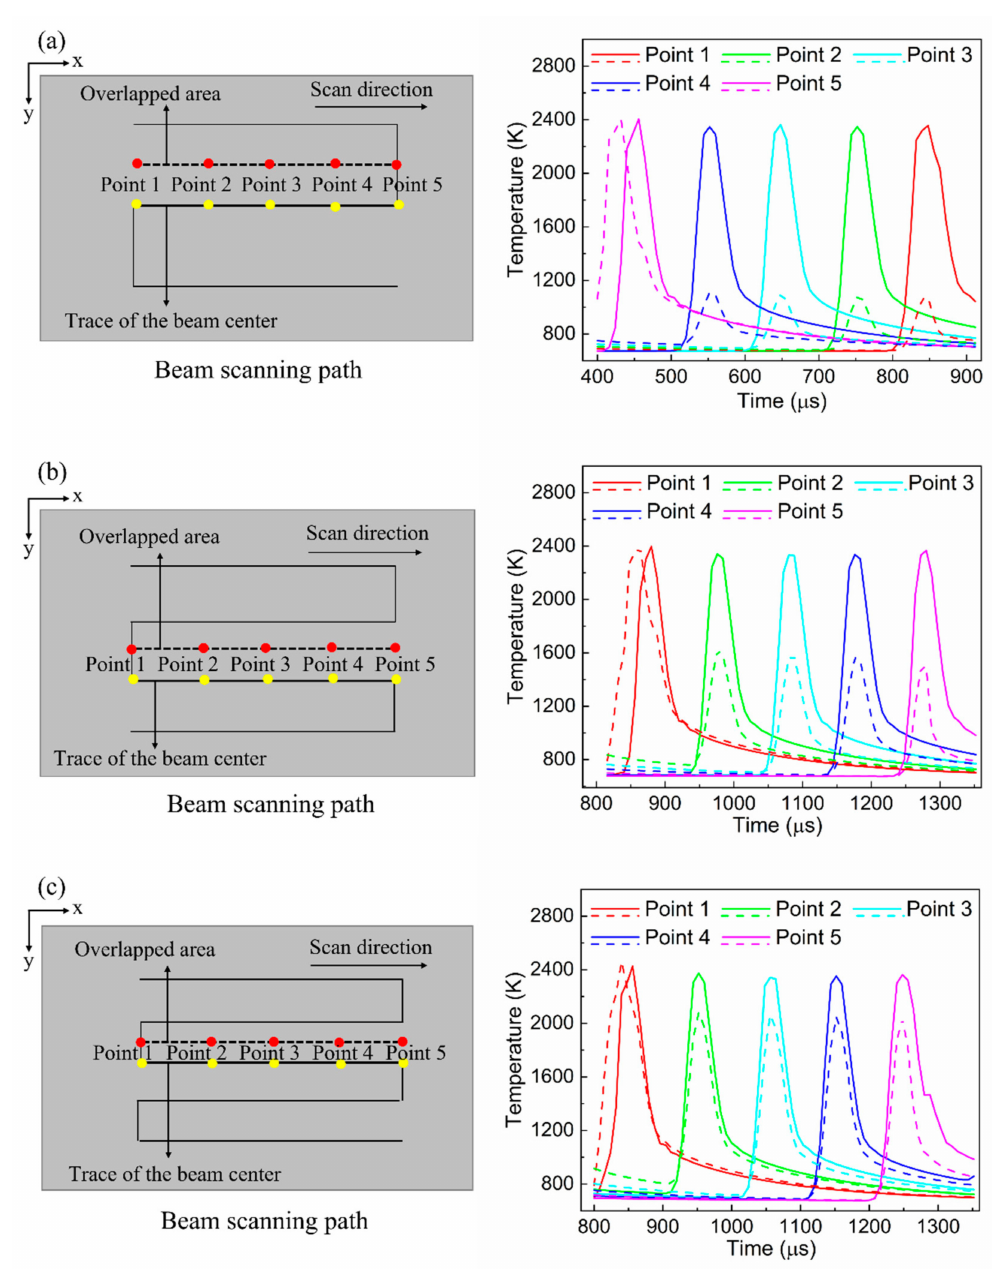
Figure 7. Schematics of beam-scanning path (each pair of red and yellow spot at a particular point has the same coordinate on the y-axis) and surface temperature evolution: ( a ) 0% overlap ratio, ( b ) 25% overlap ratio, and ( c ) 50% overlap ratio. Dotted lines and solid lines indicate the temperature profiles at red spots (overlapped areas) and yellow spots (scanning paths),